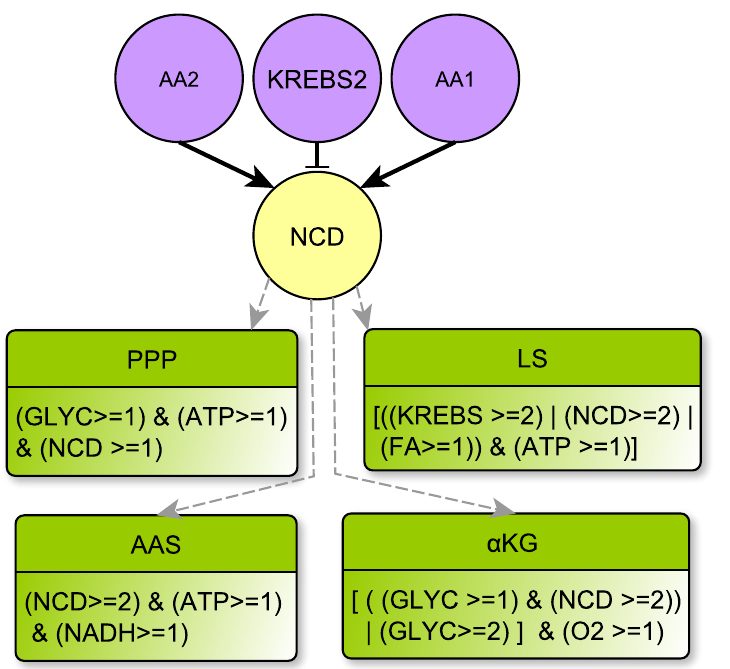
Figure 9. resources and targets for NCD .